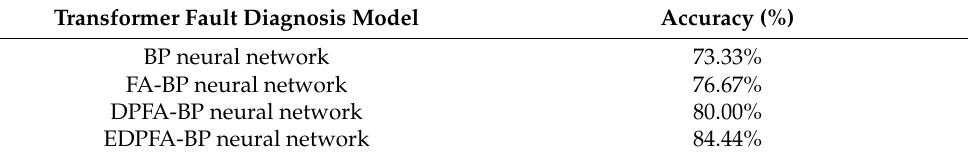
Table 8. The accuracy of each